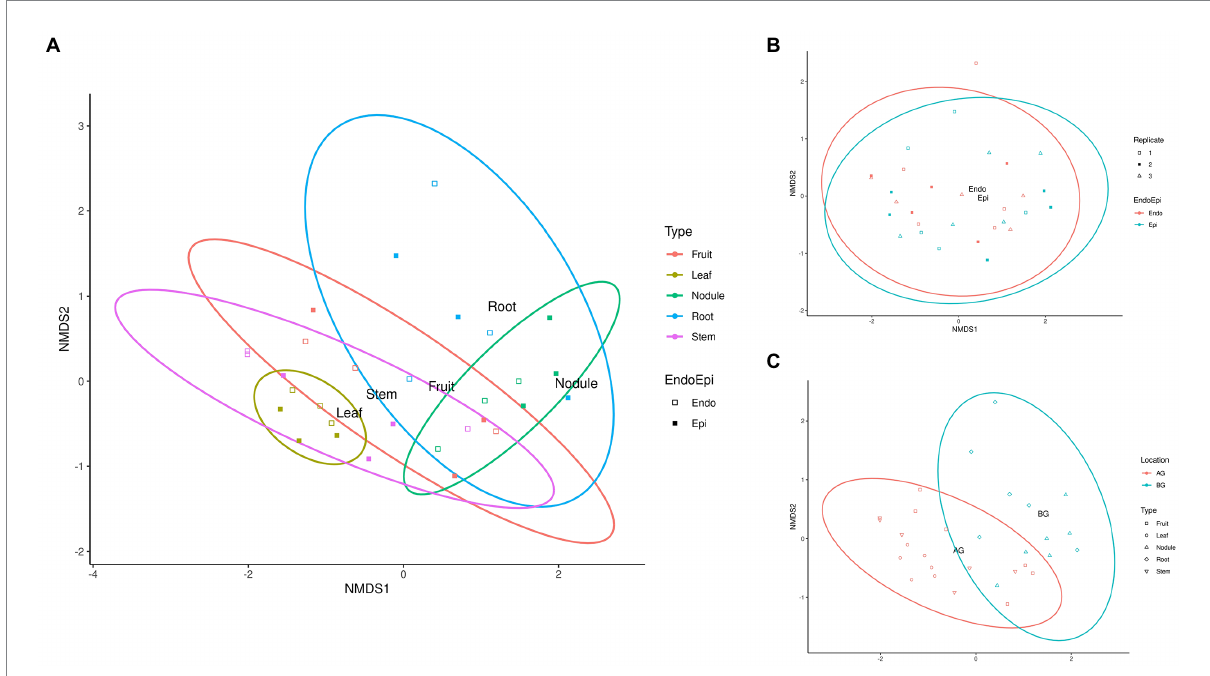
FIGURE 6 Non-metric Multidimensional Scaling (NMDS) ordination of C. myrtifolia phytomicrobiome. Ordinations of the phytomicrobiome communities were produced by the Bray-Curts distance metric. (A) shows NMDS for each plant tissue and both epiphytes and endophyte populations. Final ordination stress = 0.139. Procustes rnse <0.001, and max resid = 0.002. Point and ellipse color correspond to tissue type and point fill corresponds to endophyte (unfilled) and epiphyte (filled) samples. (B) shows NMDS for the epiphyte and endophyte communities. Final ordination stress = 0.139, Procrustes rmse <0.001, and max resid = 0.002. Point and ellipse color correspond to epiphyte (blue) and endophyte (red) samples. Point shape and fill correspond to sample replicate. (C) shows NMDS for the above- and below-ground phytomicrobiome communities. Final ordination stress = 0.139, Procrustes rmse <0.001, and max resid = 0.002. Point and ellipse color correspond to above ground samples (AG: fruit, leaf, and stem), and below ground samples (BG: root and nodule). Point shape corresponds to sample types with endophyte and epiphyte samples